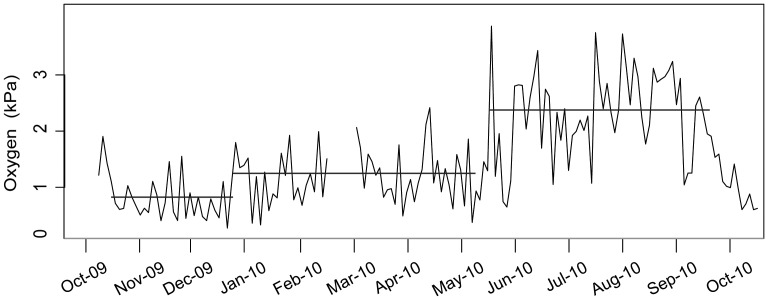
Dissolved oxygen levels at 102 m depth on the camera platform (DCF) in Saanich Inlet for the time of the study.Plotted values are averages of the measurements every minute in the hour encompassing the image capture. Horizontal bars are mean values representing three distinct periods of progressively less severe hypoxia, from October 13, 2009 to January 1, 2010 (average O2 = 0.81 kPa), from January 4, 2010 to May 3, 2010 (average O2 = 1.24 kPa) and from May 5, 2010 to September 20, 2010 (average O2 = 2.17 kPa).